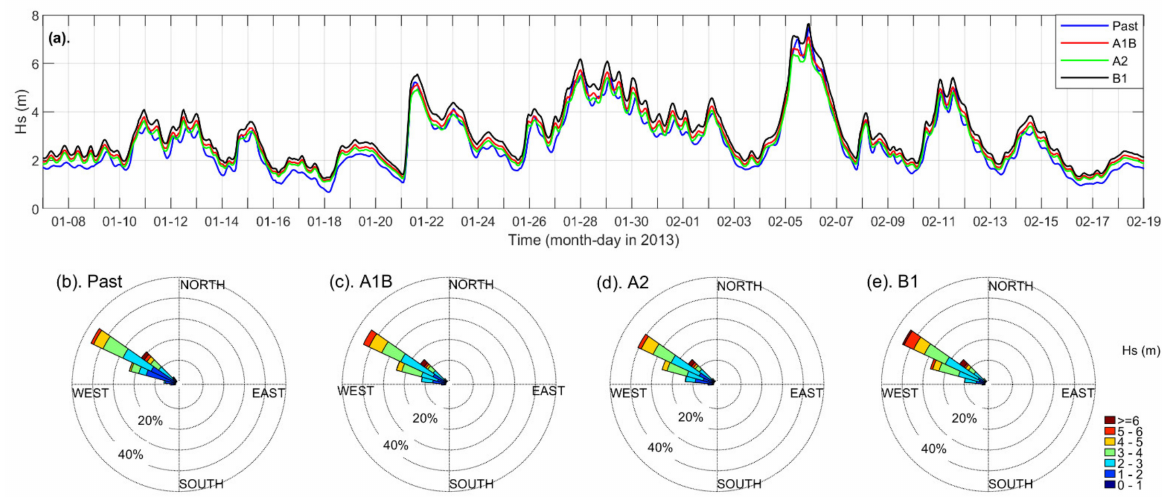
Figure 3. Comparison of ( a ) wave height and wave roses during the ( b ) historical period from 7 January–18 February 2013, and ( c ) A1B, ( d ) A2, and ( e ) B1 future wave projections at W1.